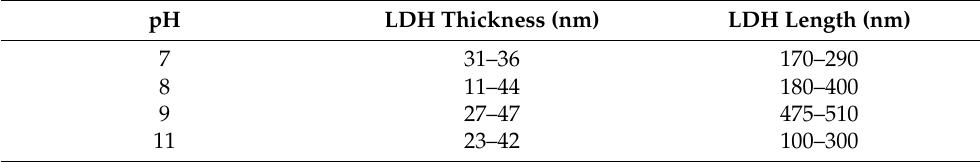
Table 3. LDH particle thickness and length versus pH.